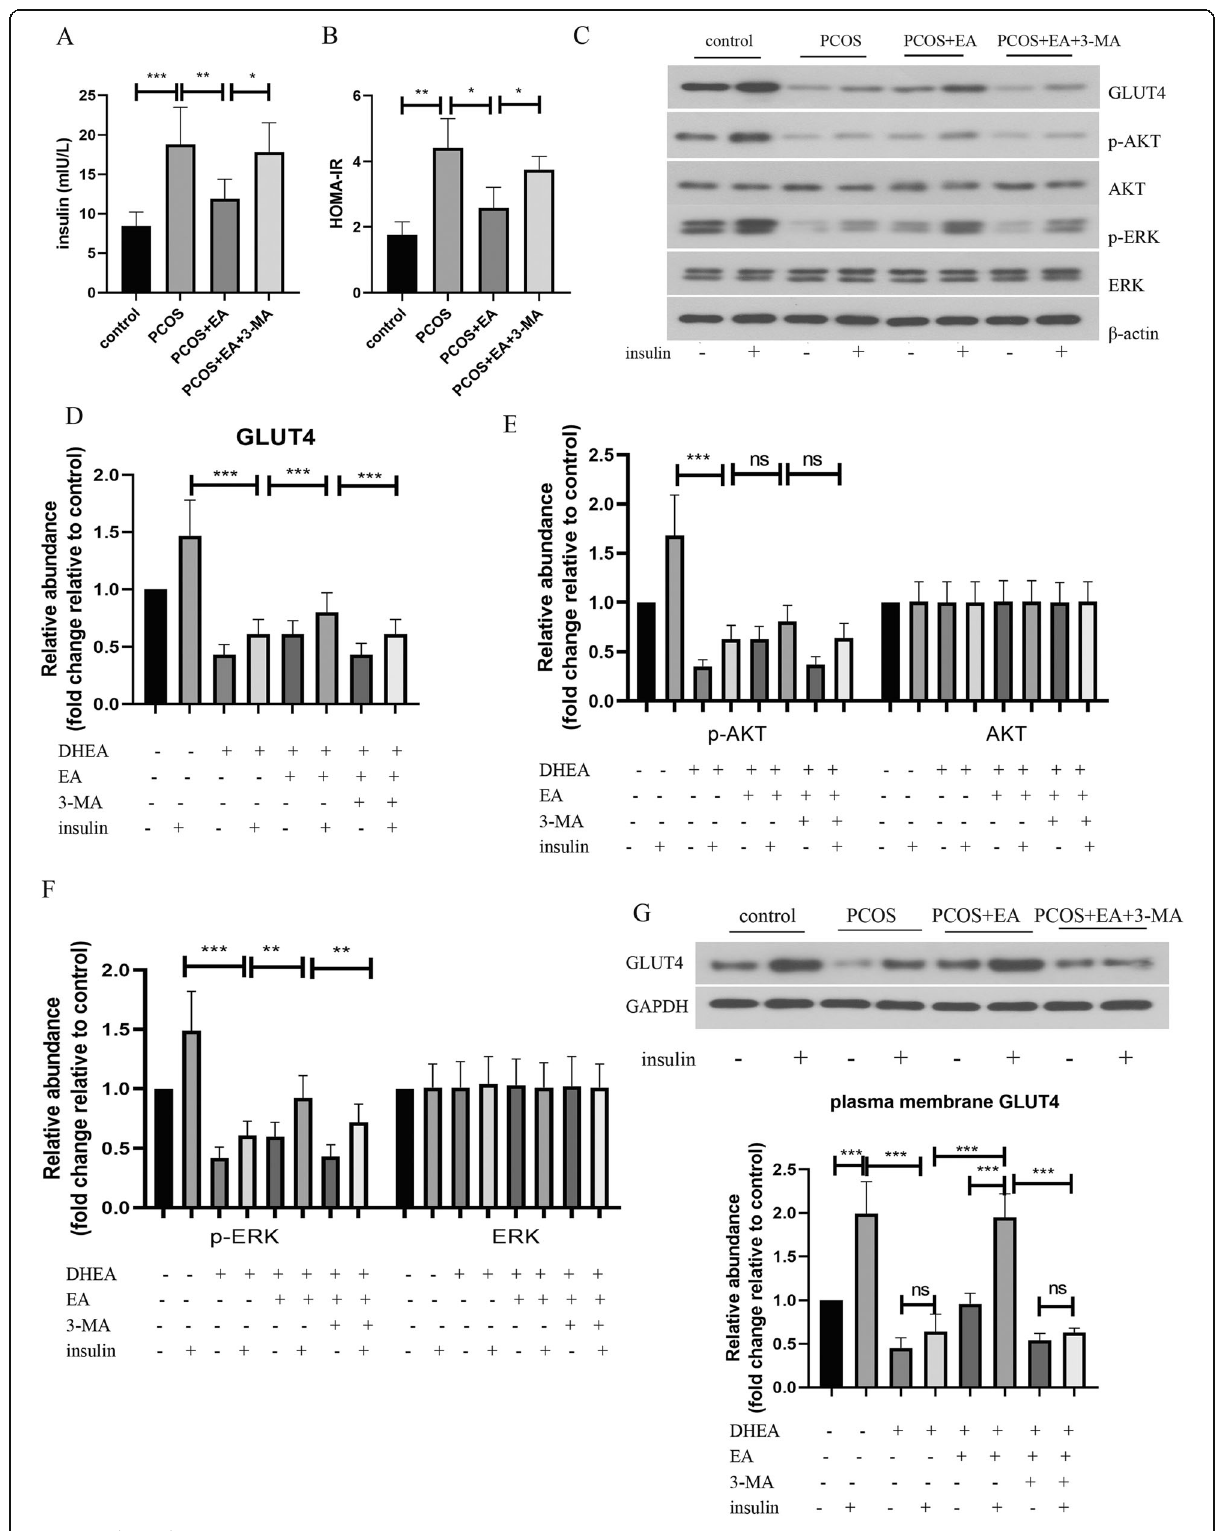
Fig. 3 (See legend on next